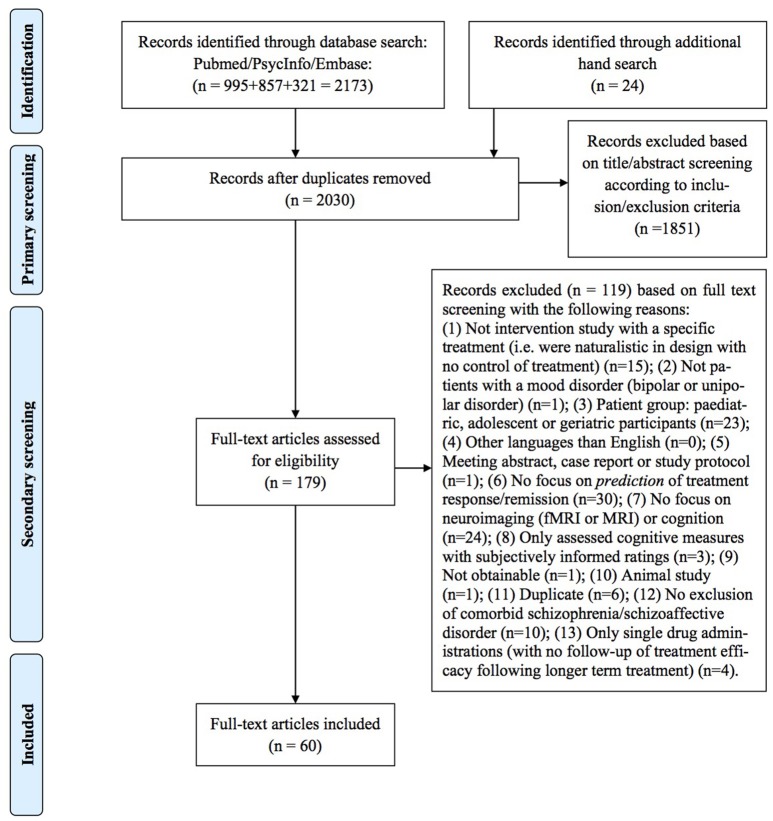
PRISMA flow-chart.